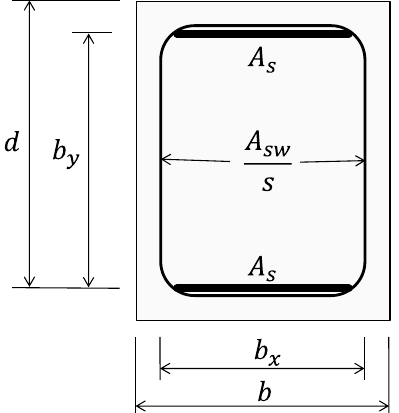
Figure 2. Moment-curvature relationship of a column section with the corresponding limit state criteria for Damage limi- tation Limit State (DLS, tension steel yielding), Life safety Limit State (LLS, concrete cover crushing), and Collapse pre- vention Limit State (CLS, concrete core crushing).